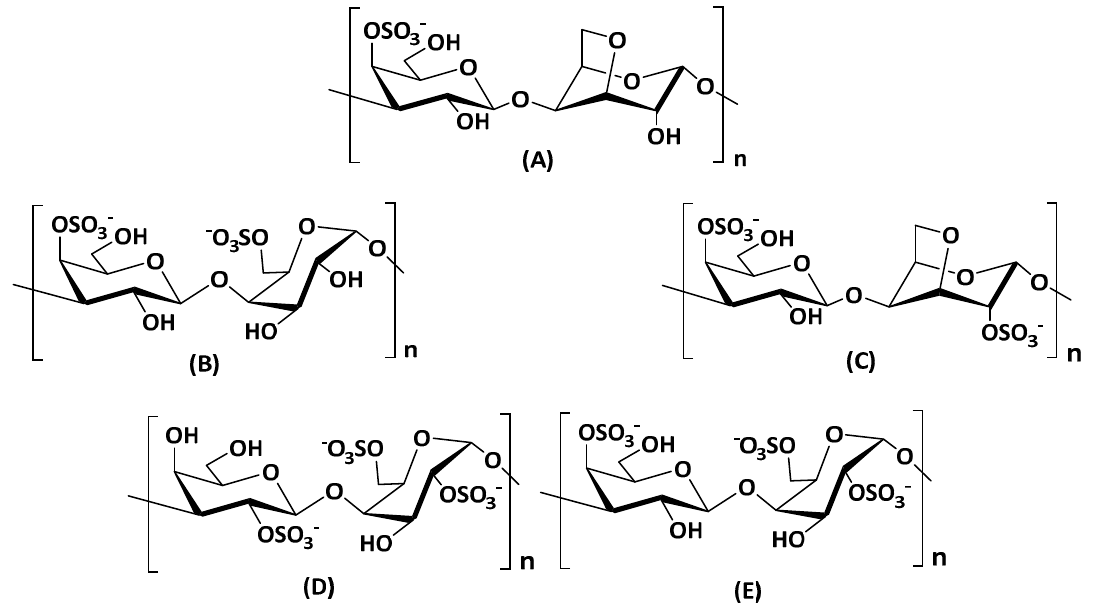
Figure 15. Main chemical structures of carrageenans. ( A ) κ -carrageenan, ( B ) µ -carrageenan, ( C ) ι -carrageenan, ( D ) λ -carrageenan and ( E ) ν -carrageenan.